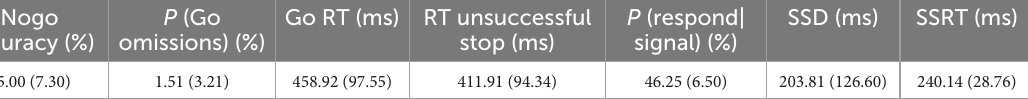
TABLE 1 Behavioral data of SST